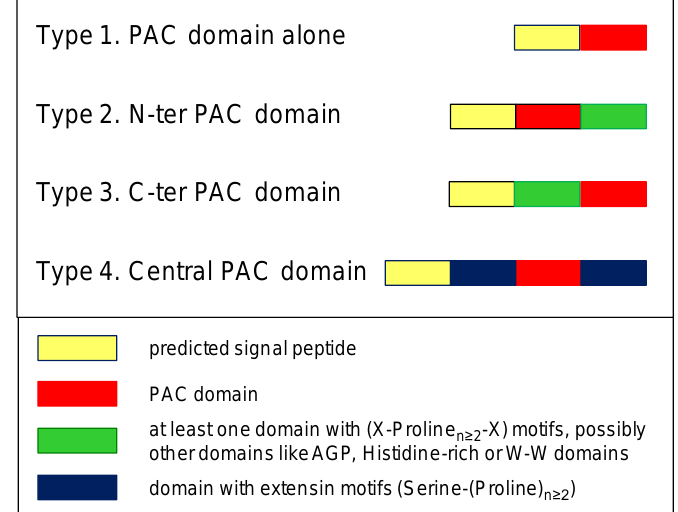
Figure 2. Classification of PAC domain proteins according to the location of the PAC domain and associated domains. Type 1. Proteins containing the PAC domain alone. Type 2. Proteins containing the PAC domain at their N-terminus together with another (several other) domain(s). Type 3. Proteins containing the PAC domain at their C-terminus together with another (several other) domain(s). Type 4. Proteins containing the PAC domain in a central position flanked by two domains with extensin motifs (Serine-(Proline) n ≥ 2 ).